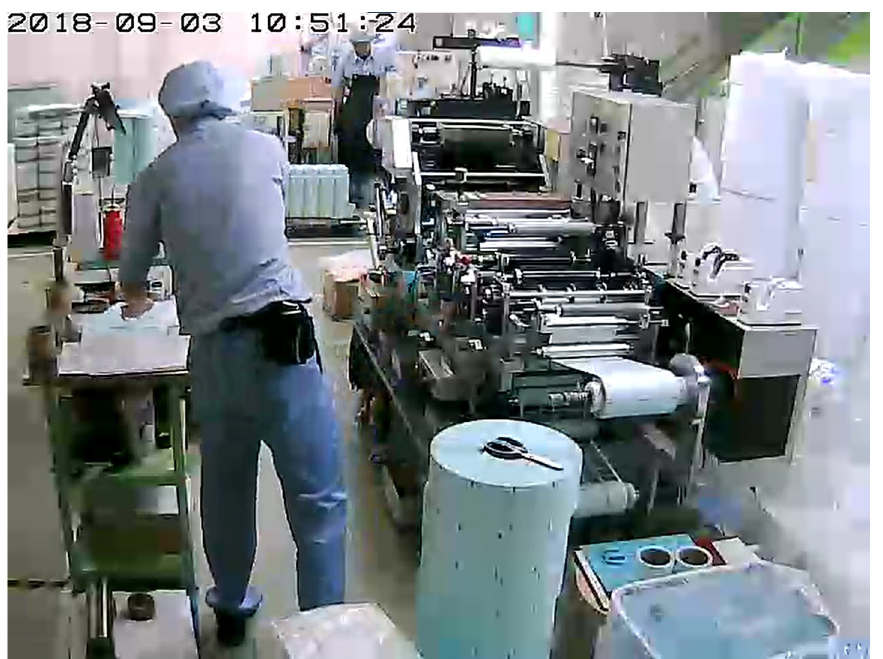
Fig 1. Sample frame of proposed factory video